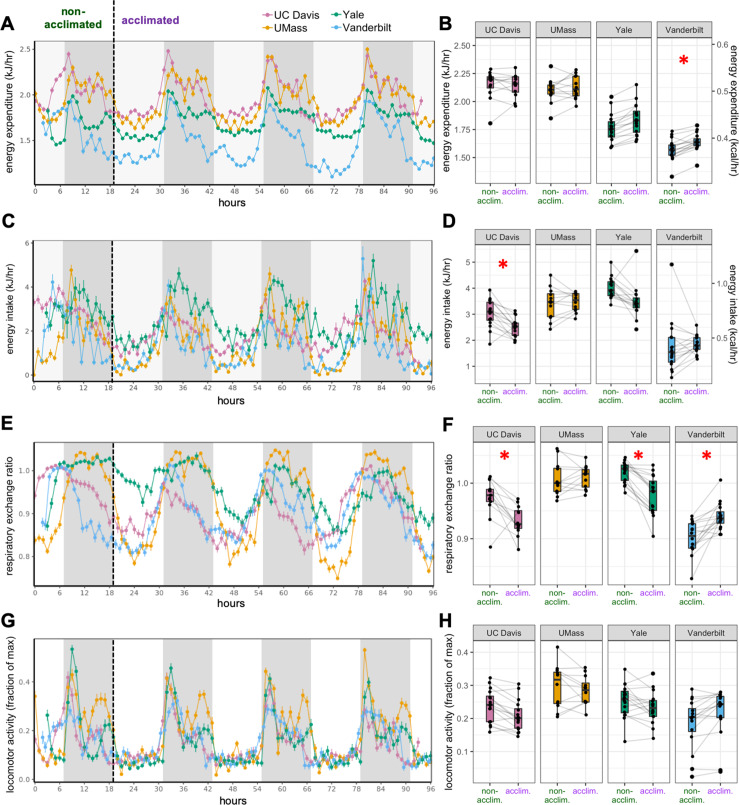
MMPC experiment: effect of acclimation.Plots of metabolic variables vs time are shown for mice on LFD (0 weeks). EE vs time (A). Mean values for the first dark photoperiod vs the mean of the subsequent three dark photoperiods at each site of the MMPC experiment (B). Energy intake (C, D); RER (E, F); Locomotor activity (G, H). Values are hourly means. *, p<0.05. n = 6–8 males per group. Error bars represent SEM. Shaded regions represent the dark or active phases from 18:00 to 6:00.